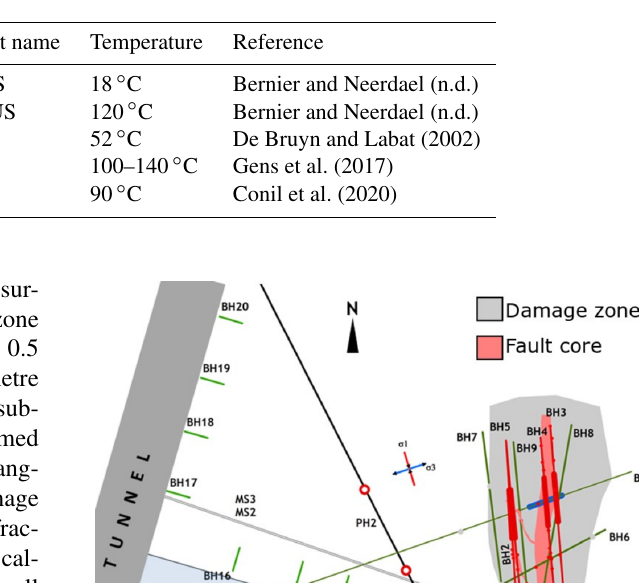
Table 1. Table presenting previous heating experiments performed in URLs dedicated to research on clay rich materials in western Europe.